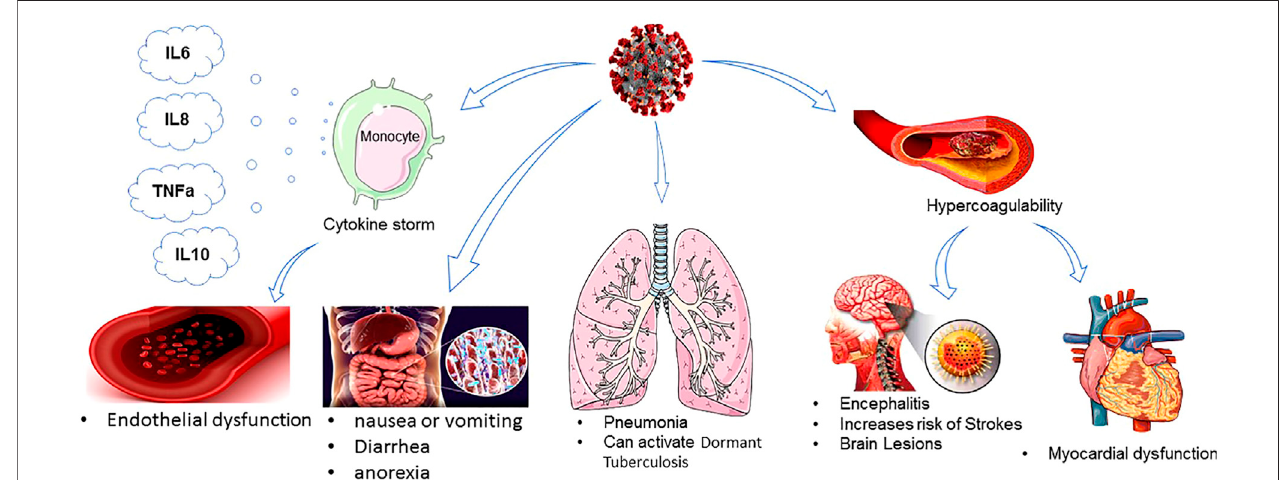
FIGURE 1 | COVID-19 effect on different